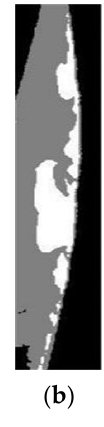
Figure 8. Comparison of the rake face images ( a ) before and ( b ) after segmentation based on MRF model.